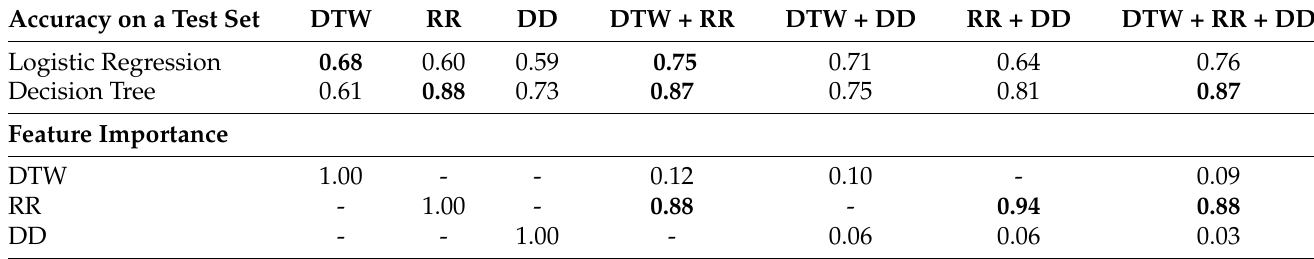
Table 6. Discriminating ability of DTW and CRQA feature